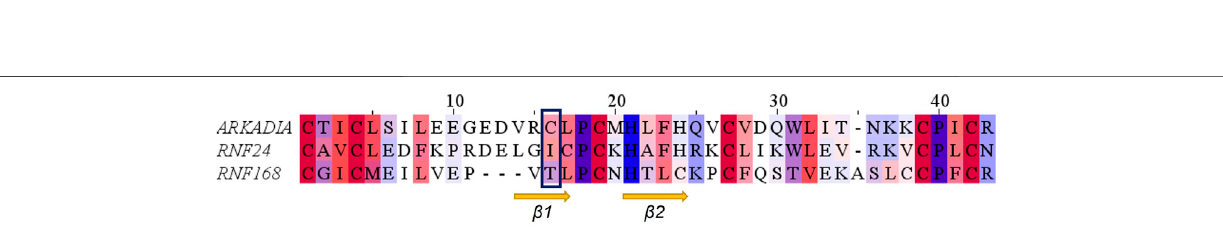
Frontiers in Molecular Biosciences |